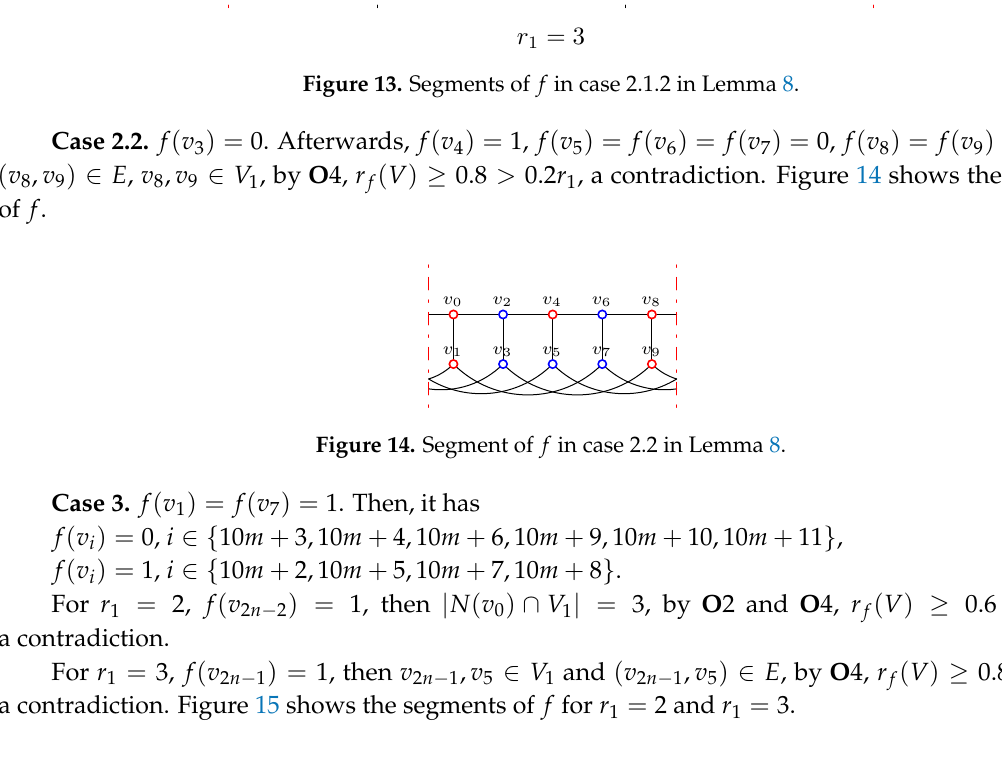
Figure 13. Segments of f in Case 2.1.2 in Lemma 8.